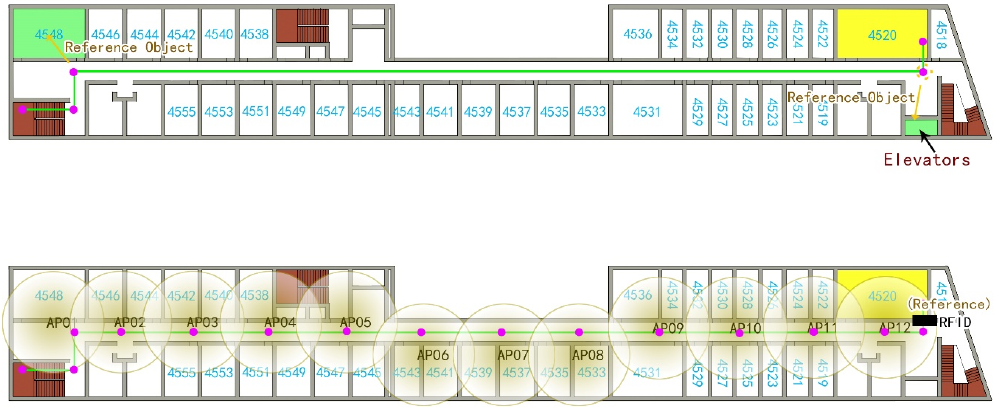
Figure 5. Indoor navigation for humans ( top ) and robots ( bottom ).